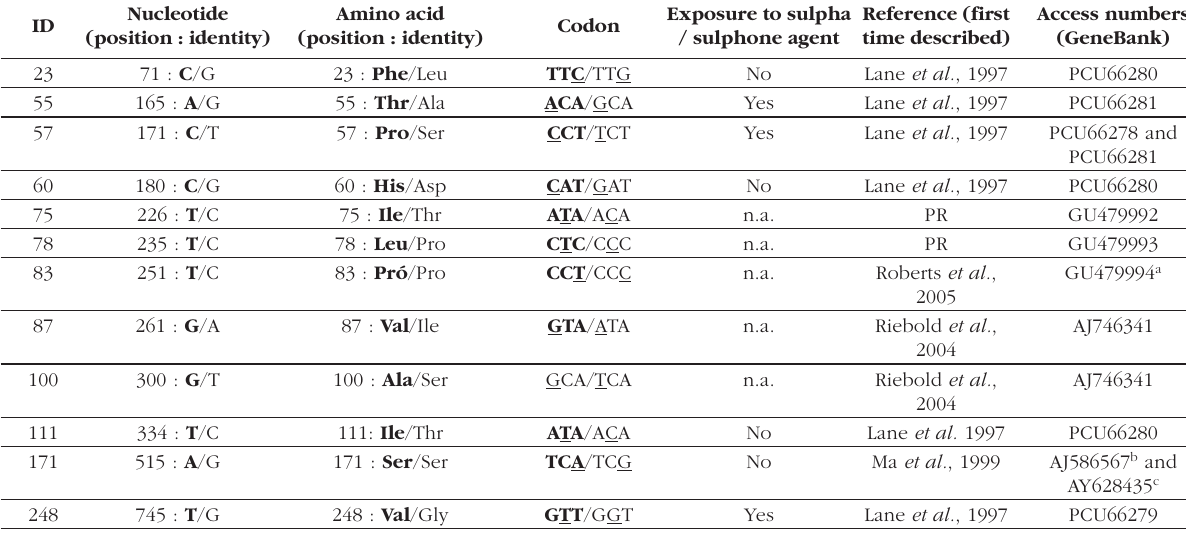
Table I. – Sequence variations of P. jirovecii DHPS